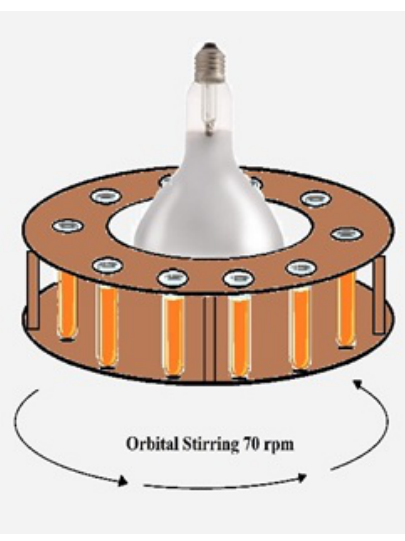
Figure 1: Setup for the photocatalytic assays.